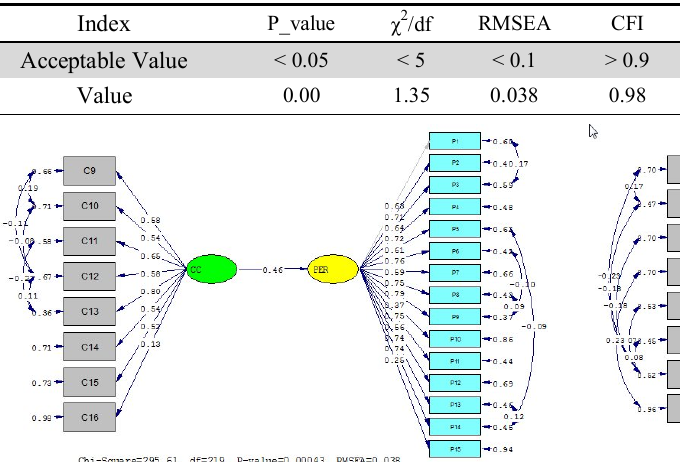
Fit indexes of model 3